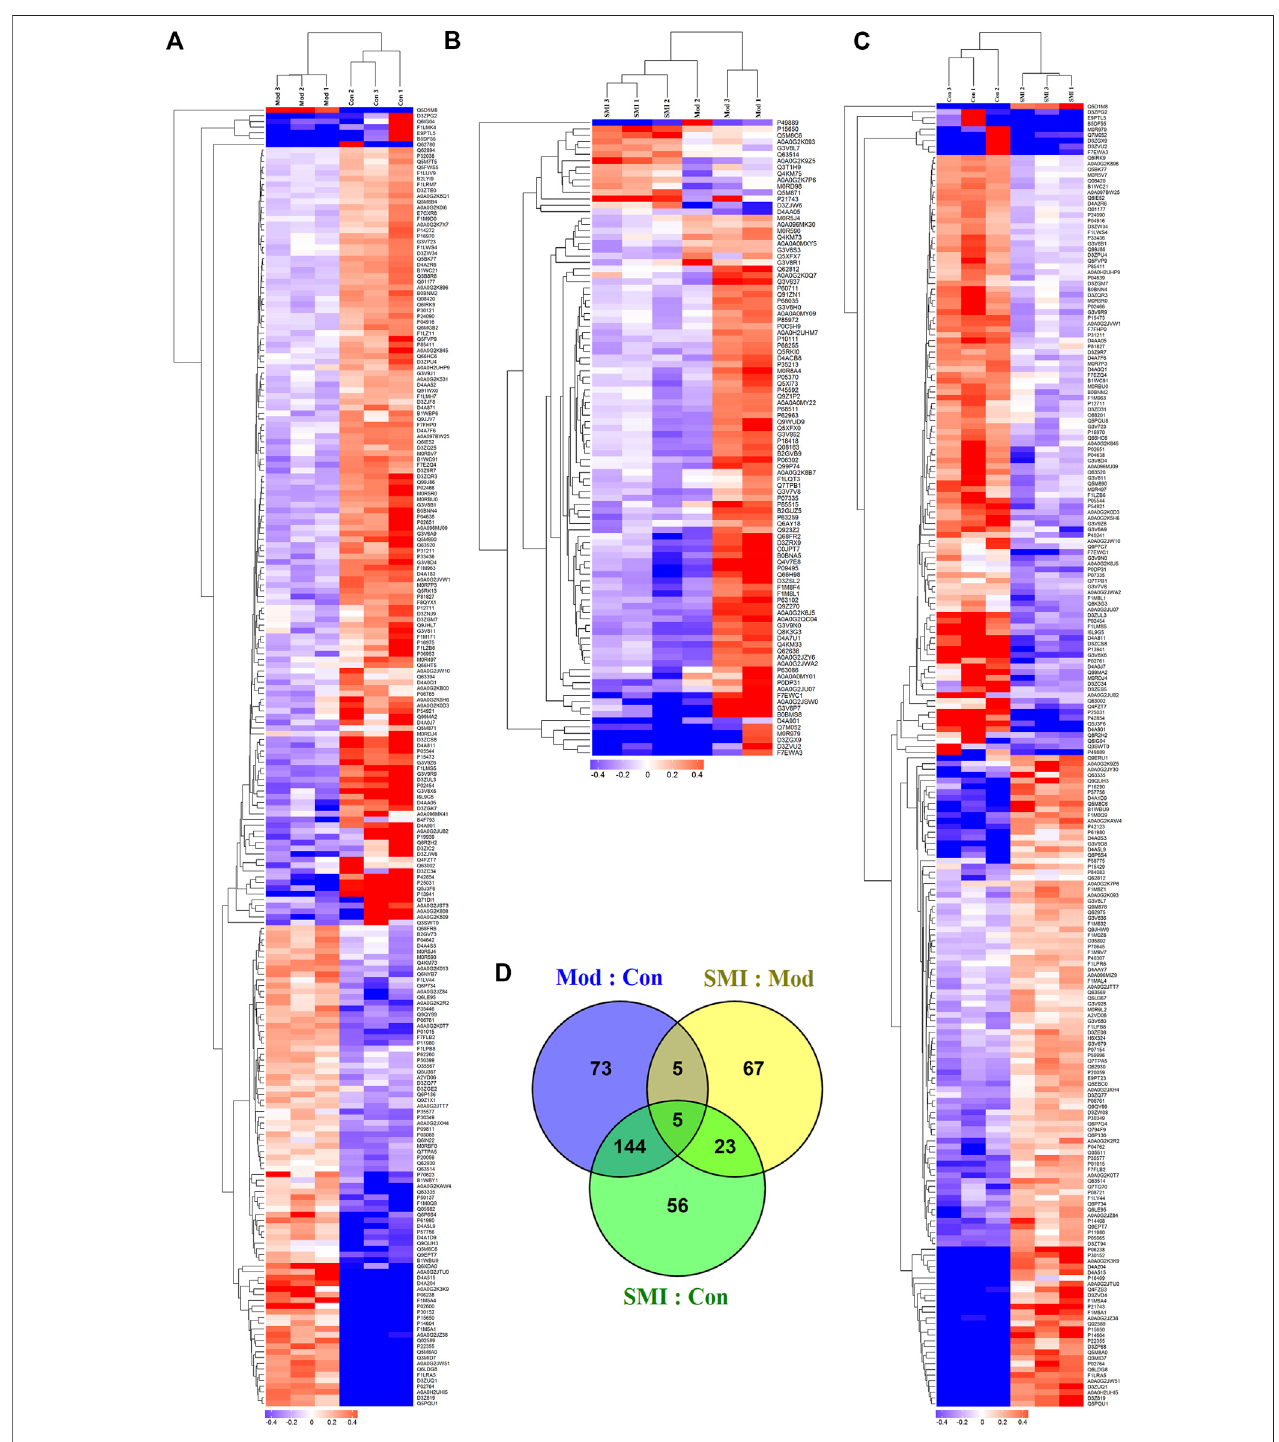
FIGURE 3 | Differentially expressed proteins (DEPs) pro fi les by TMT-based proteomic analysis. (A, B, C) Heat maps of the overall differential concentrations of proteins quanti fi ed in Mod: Con (A) , SMI: Mod (B) , and SMI: Con (C) , respectively. (D) Venn diagram showing overlap of all DEPs among Mod: Con, SMI: Mod, and SMI: